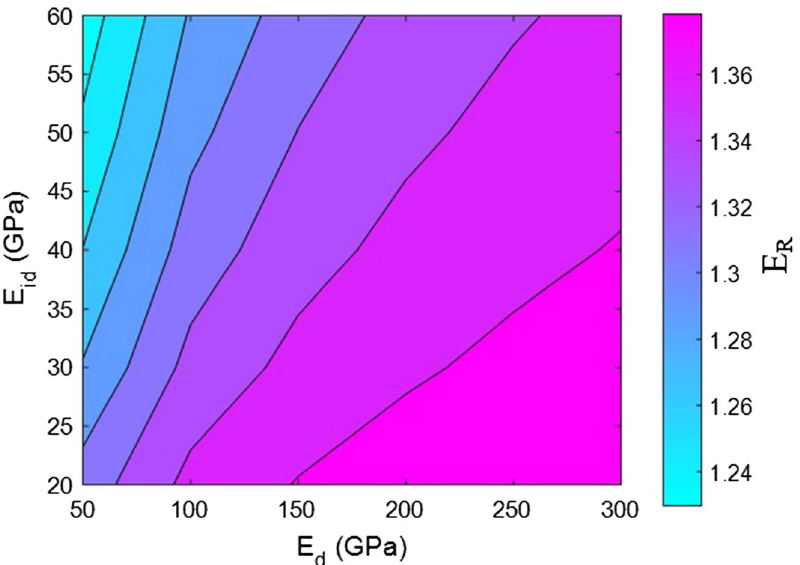
Figure 4. Calculations of relative modulus for various moduli of dispersed HNTs and adjacent interphase